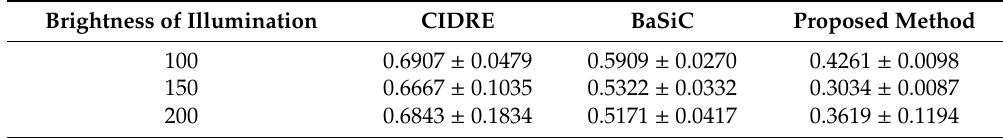
Table 1. Comparison of correction scores according to the brightness of the